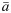
Validation of the approximate sensitivity estimation (13).The true relative errors in a with respect to changes in each parameter are shown in blue, corresponding approximations by Taylor expansion are in red (up to the second order term for T and the linear term for R and BMDref) and green (the linear term for T). First row is for variation in BMDref (left) and T (right) at the a¯ level of 0.5 (“thin” cortex), second row is for variation in BMDref and T at the thickness level a¯=3.5 (“thick” cortex). In the third row there are results for T (left, a¯=1.64) and R (right, a¯=0.5). For the very thick cortex, a¯=3.5, analytic sensitivity is not shown, as the true sensitivity becomes highly nonlinear due to vicinity of the singular point T = 1 (bottom left and center) and the Taylor expansion with the two first terms does not approximates it well except for a very small neighborhood of the initial value. BMDref was set to 1000 mg/mm, R=13, σ was 1.